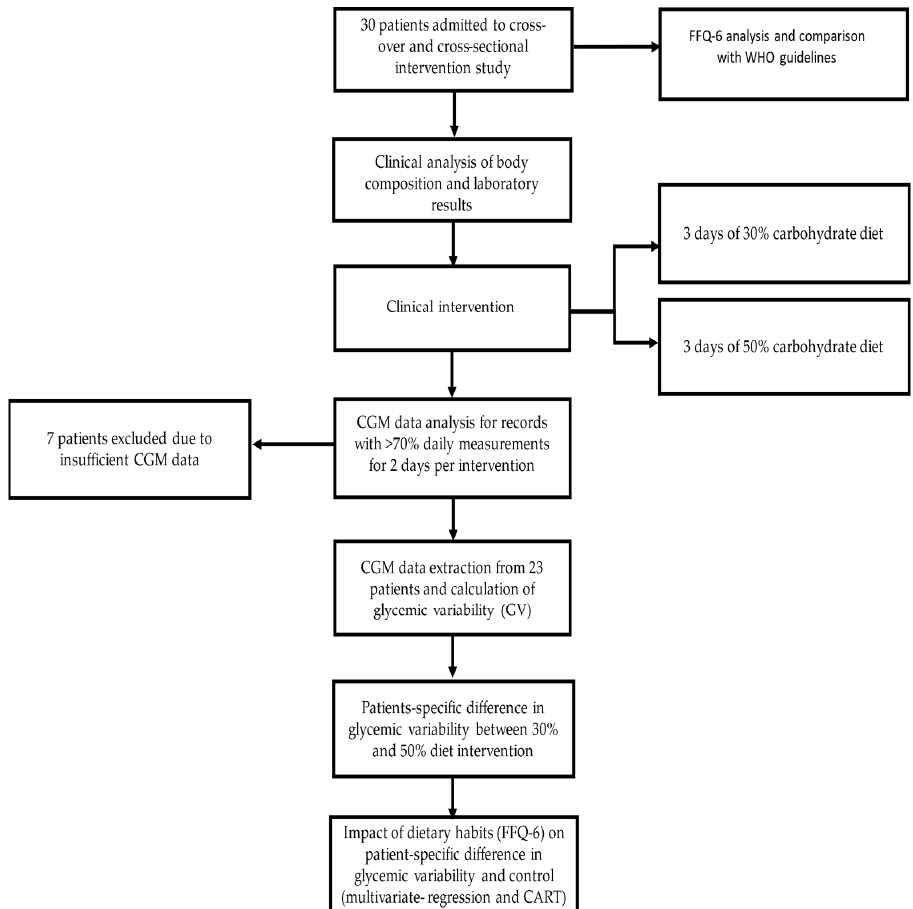
Figure 1. Study design and analysis diagram.